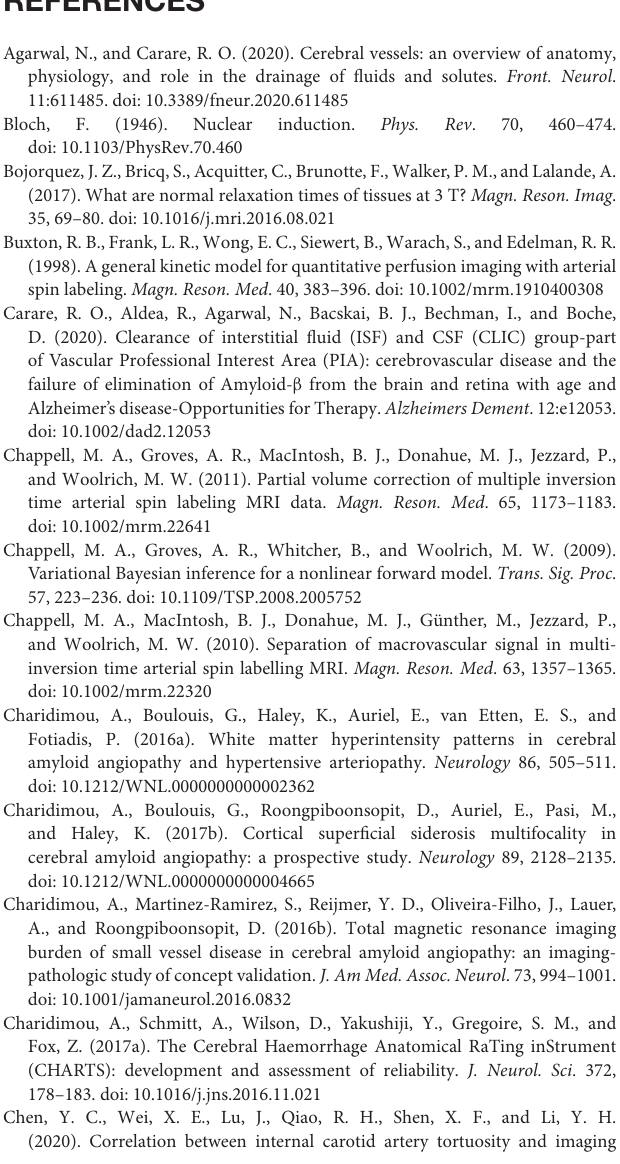
Supplementary Figure 1 | Correlation matrix of the CSVD sum score (CSVD-score), white matter hyperintensities (WMHs) related to FAZEKAS scale